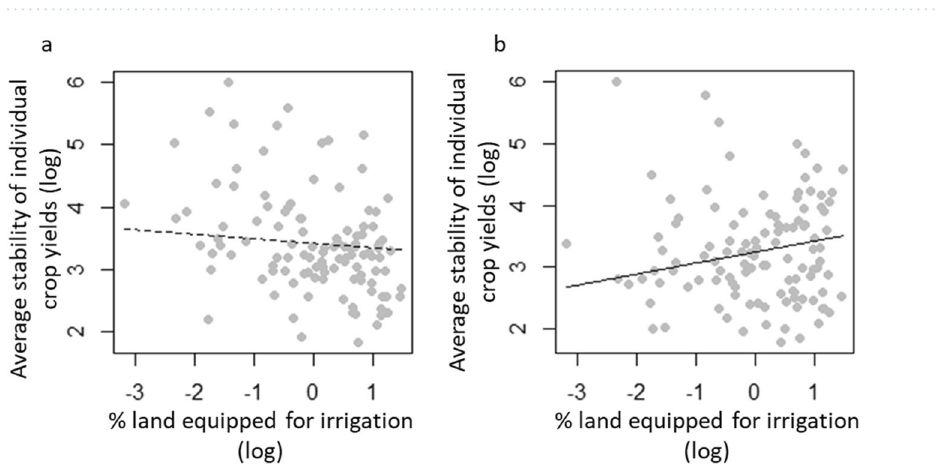
Figure 3. Effects of crop diversity on asynchronous dynamics among crop yield fluctuations. Black lines show the relationships estimated by the structural equation model when the crop yields are non-weighted ( a ) and weighted ( b ) by the proportion of cropland occupied by each crop within a country.